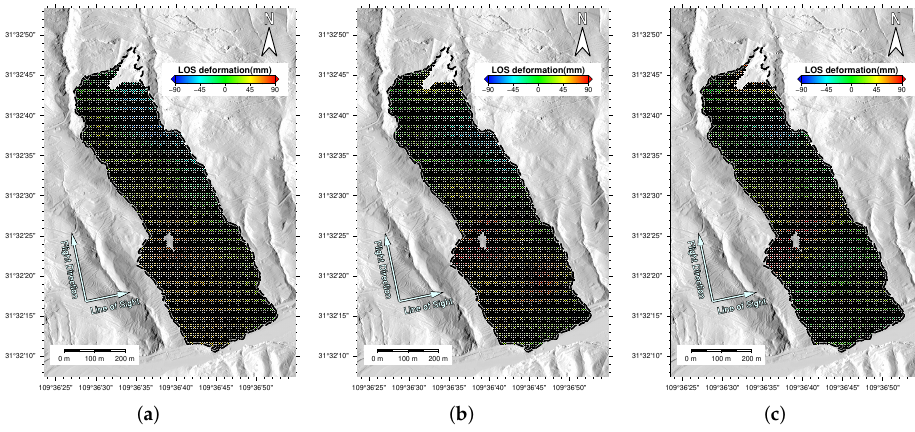
Figure 8. The cumulative LOS displacement maps of the three landslide movement stages: ( a ) S1: post-failure stage, ( b ) S2: post-failure + reactivation stage, and ( c ) S3: reactivation